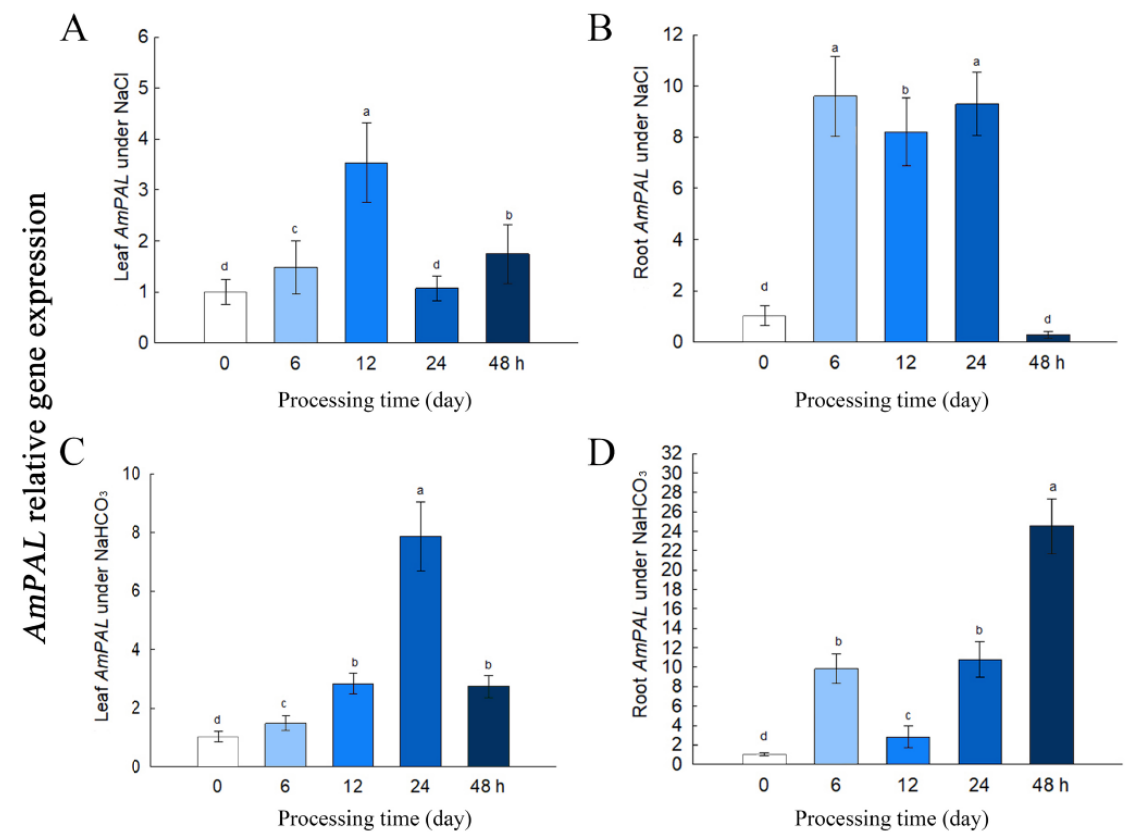
Figure 3. Gene expression of AmPAL under 150 mM NaCl or 60 mM NaHCO 3 for 0, 6, 12, 24, and 48 h. ( A ) Leaf AmPAL under NaCl. ( B ) Root AmPAL under NaCl. ( C ) Leaf AmPAL under NaHCO 3 . ( D ) Root AmPAL under NaHCO 3 . Statistical differences are denoted with letters at p < 0.01. Data represent mean ± SD from three biological